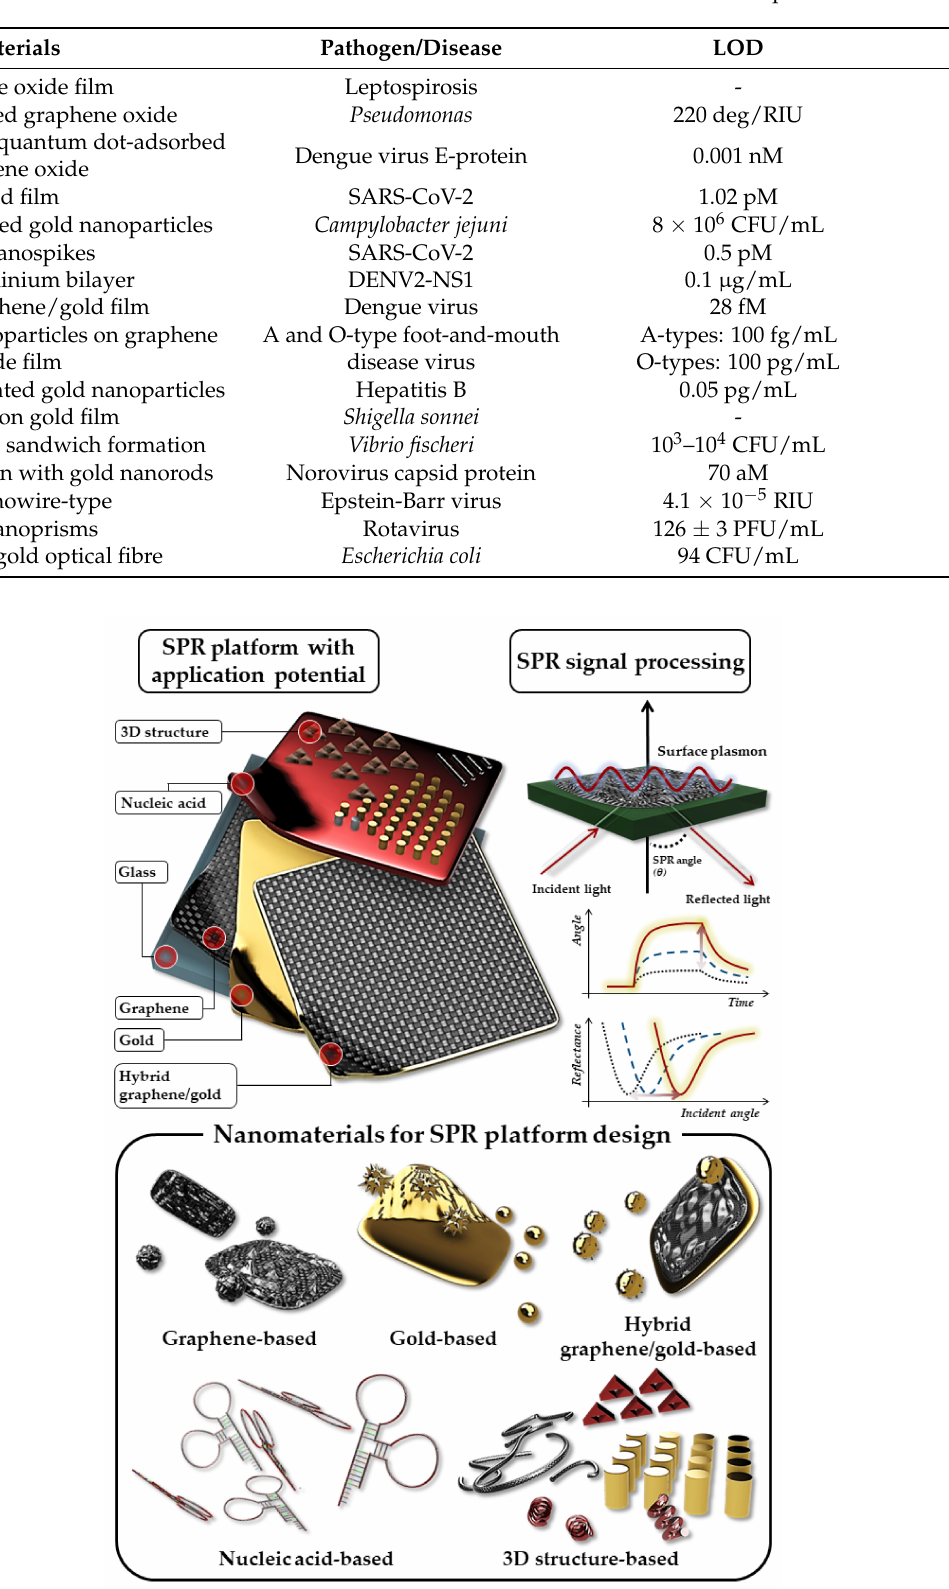
Table 1. Materials used for the construction of SPR sensors for the optical detection of pathogens.